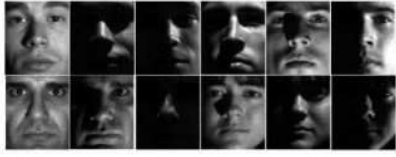
Figure 2. Extended